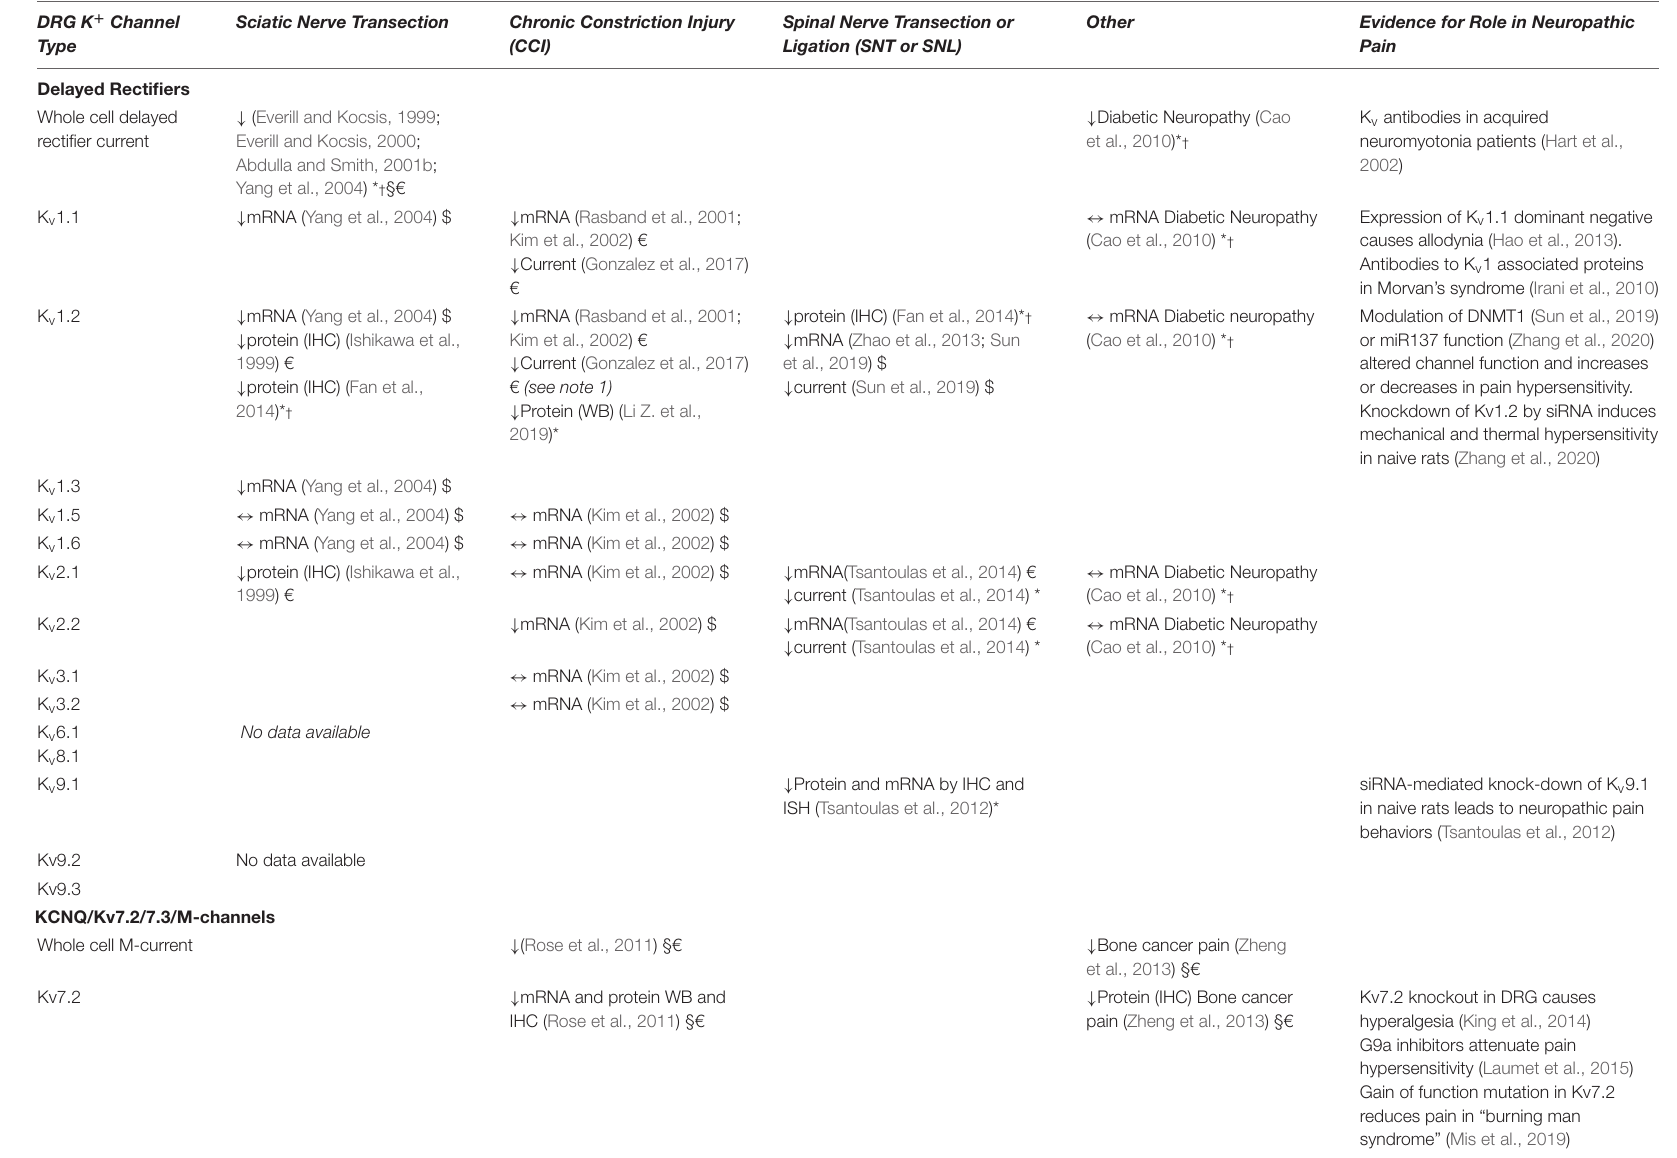
TABLE 1 | Known changes in K + channel function in DRG following various types of peripheral nerve injury ( ↑ , increase; ↓ , decrease; ↔ , unchanged; *, in large cells only; † , in medium sized cells only; §, in small IB4 positive neurons; €, in small IB4 negative neurons; $, neuron type unspecified. DRG K +